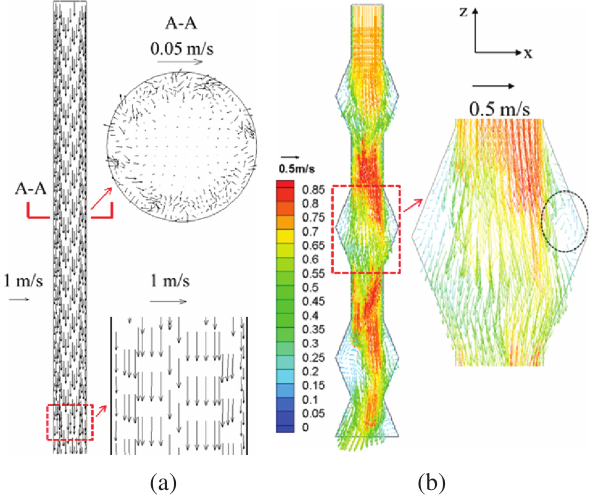
Figure 4: Typical velocity vector profiles, with enlarged transversal and longitudinal section of the (a) CLS and (b) DLS at the central XZ